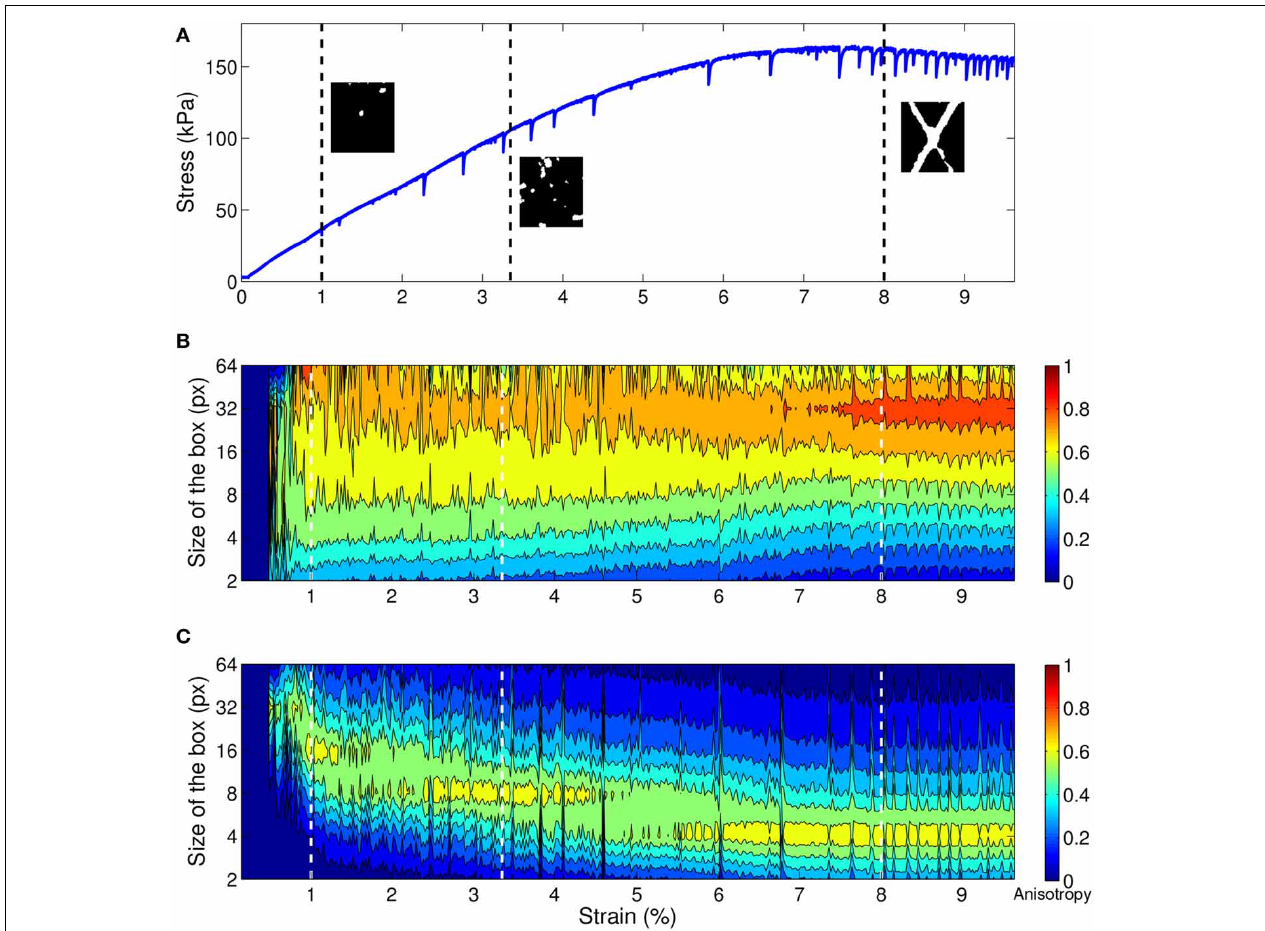
FIGURE 7 | Analysis of correlation patterns in precursors to the rupture of a granular material (Figures 1C–H). (A) Loading curve: deviatoric stress σ zz − σ xx vs. the global axial deformation ε = (cid:9) L / L . Inserts : images used for the analysis obtained from the correlation maps of Figures 1D,E,G . (B) Anisotropy vs. strain and box size for the whole experiment (see color code on the right side: red =